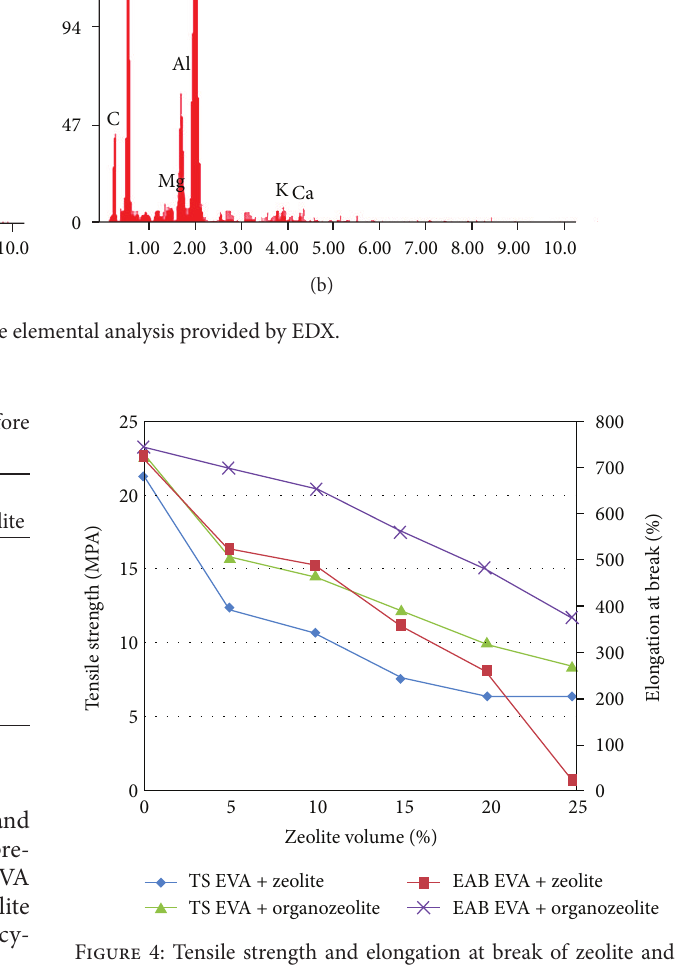
Figure 4: Tensile strength and elongation at break of zeolite and organozeolite EVA